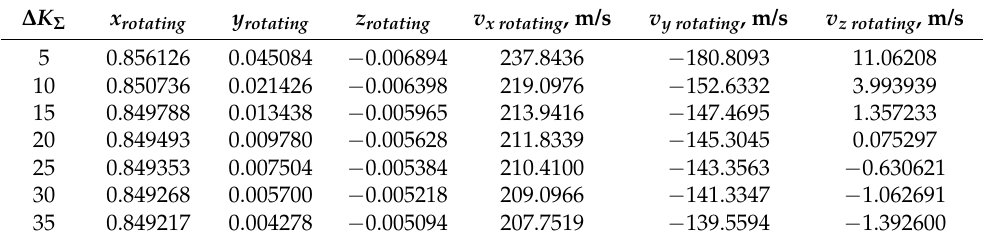
Table 3. The magnitudes of adimensional position and dimensional velocity vectors of the optimal junction point in the rotating coordinate system.